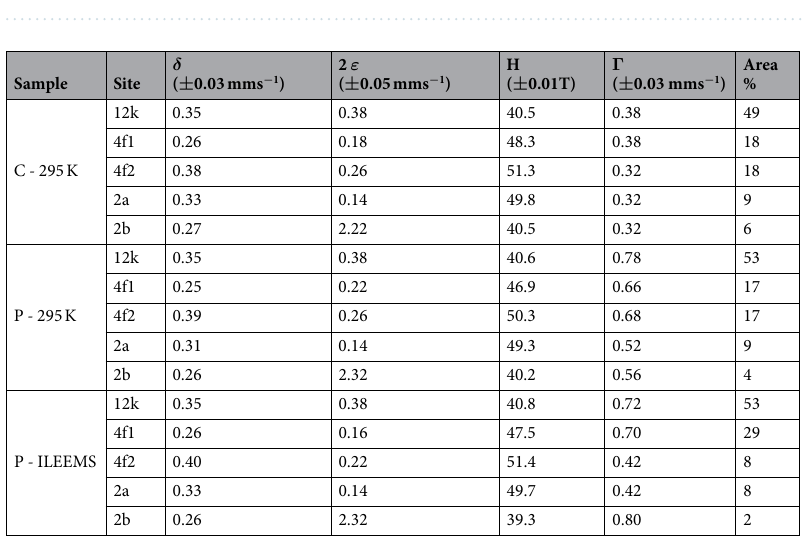
Table 1. 57 Fe Mössbauer parameters obtained from the fit of the spectra recorded in Fig. 4 at 295 K, being SFO commercial (C), SFO platelets (P) and SFO platelets measured by ILEEMS (P - ILEEMS). The symbols δ , 2 ε , H, Γ correspond to isomer shift, quadrupole shift, hyperfine magnetic field and linewidth,